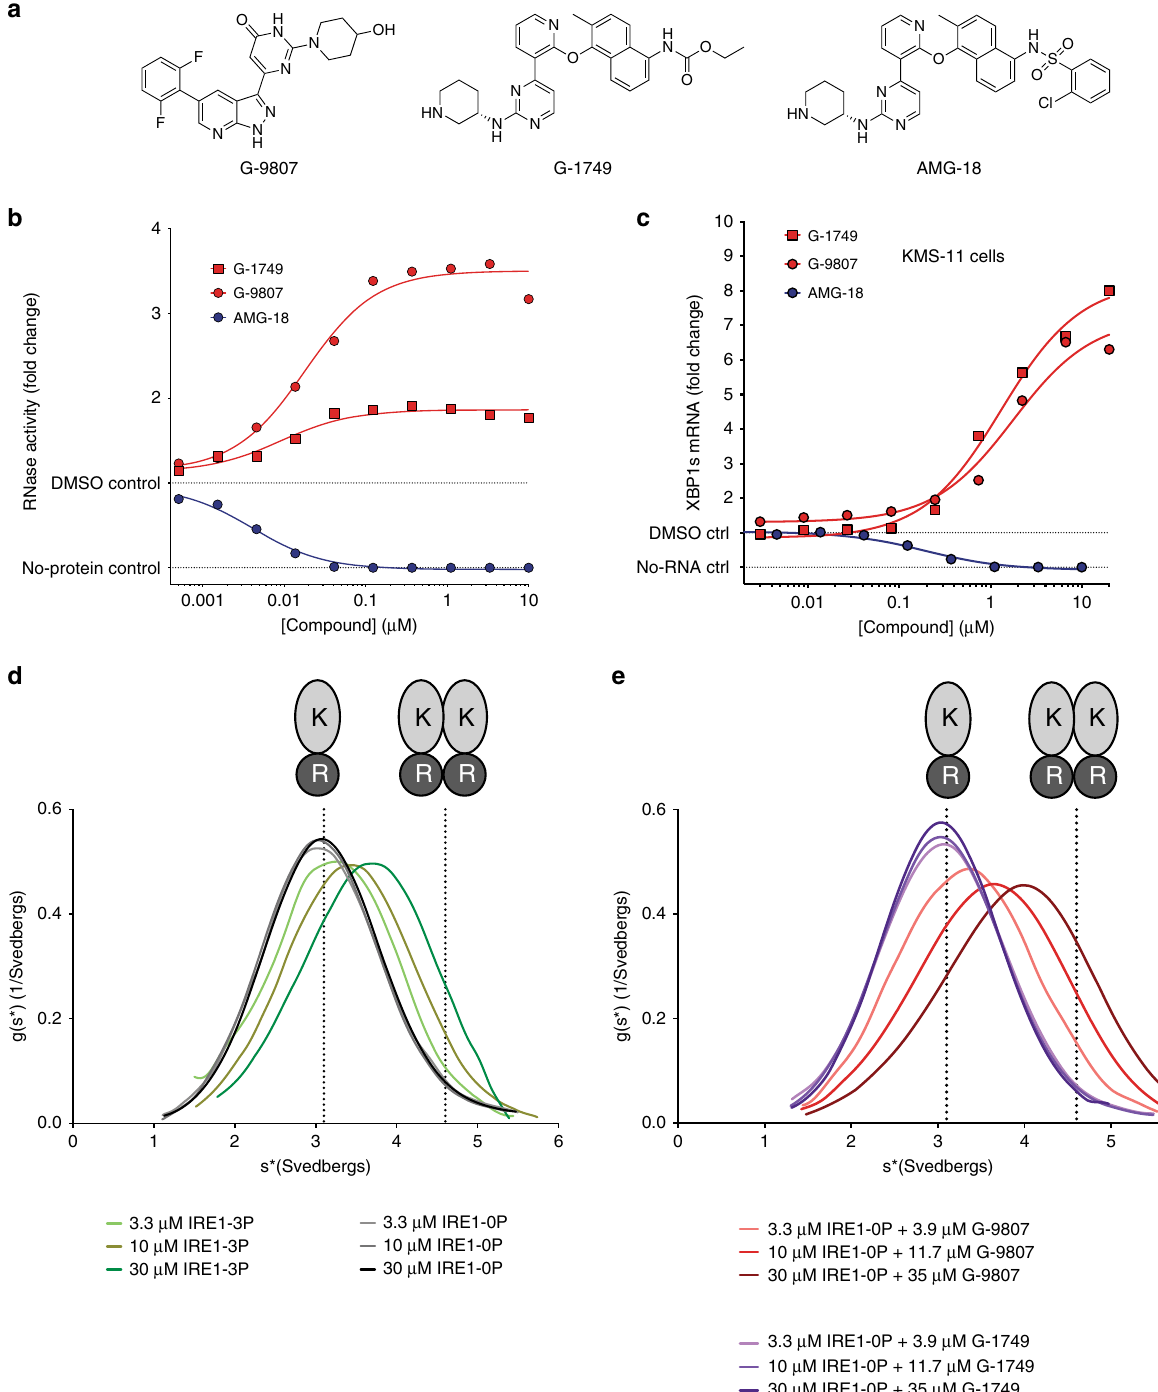
Fig. 1 Characterization of IRE1 kinase inhibitors. a Chemical structures of IRE1 kinase (K) inhibitors. b IRE1 RNase (R) activity in the presence of compounds in panel a . RNA cleavage was measured by a kinetic fl uorescence assay using an XBP1-like RNA hairpin substrate and IRE1 LKR construct (Q470-L977). Background from the no-protein control was subtracted from signal before calculating fold change. Source data are provided as a Source Data fi le. Data are presented as the mean for measurements from two independent experiments ( n = 2). c RNA levels for IRE1 RNase product XBP1s measured by bDNA assay of lysates from KMS-11 cells treated with compounds for 4 h. Background from the no-RNA control was subtracted from signal before calculating fold change. Source data are provided as a Source Data fi le. Data are presented as the mean for measurements from two independent experiments ( n = 2). d , e Analytical Ultracentrifugation sedimentation velocity (SV-AUC) experiments for ( d ), IRE1 LKR (Q470-L977) unphosphorylated and autophosphorylated and ( e ), IRE1 LKR unphosphorylated in the presence of slight excess G-9807 and G-1749. Calculated sedimentation coef fi cients for IRE1 monomer (3.1 svedbergs) and dimer (4.6 svedbergs) are highlighted by dotted lines. Source data are provided as a Source Data fi